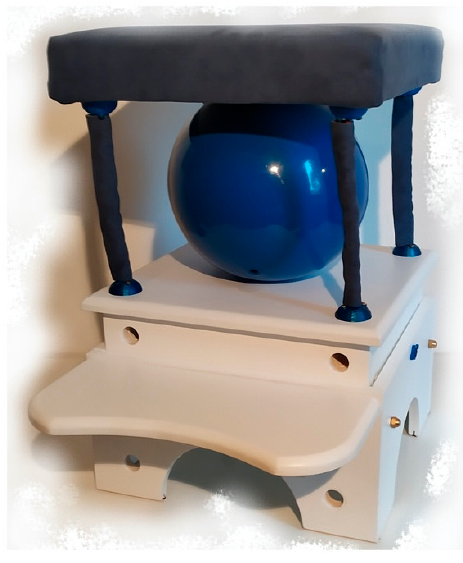
Figure 1. The “EnergyBack” dynamic stool.